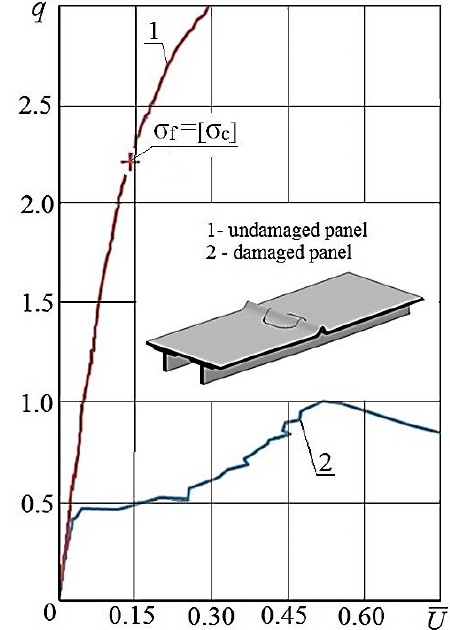
Figure 7. Displacements of undamaged and damaged panels. 𝑞 − dimensionless load; 𝑈 — dimensional displacement; σ f —actual compression stress in the fibers, [ σ c ]—ultimate compression stress of the fibers.